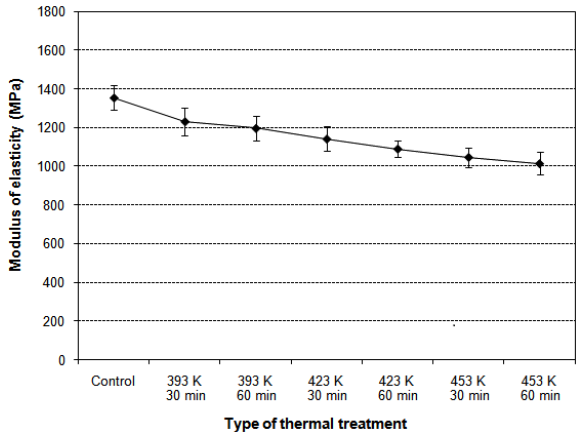
Figure 3. Effect of the thermal treatment of the wood fibers of E. camaldulensis on the modulus of elasticity of the light MDF panels. The vertical lines through the bars rep- resent the standard deviation from the average value of fourteen